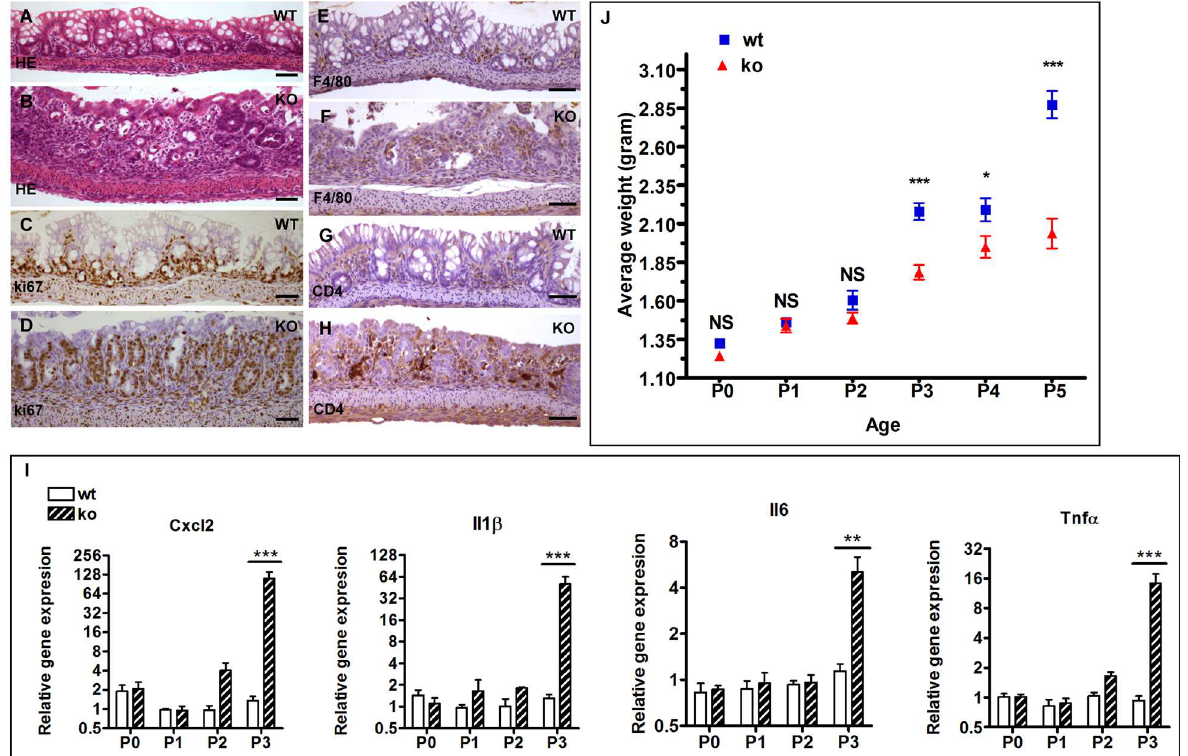
Fig 6. The IEC-specific hnRNPI knockout mice display colonic inflammation and weight gain decline at P3. (A) and (B) HE– stainedsections show the inflamedcolonicepitheliumin the knockout neonates(B). (C) and (D) Immunohistochemicalstaining with an anti-Ki67antibody shows hyperproliferation of the colonicepithelialcells in the knockout neonates. (E) to (H) Immunohistochemical stainingwith indicatedantibodiesshows increasednumber of inflammatory cells in the lamina propriaof the knockout neonates. (E) and (F) show macrophages, and (G) and (H) show CD4 positive T-cells. (I) Representative real-time PCR results show significantly increased expressionof pro-inflammatory cytokines and chemokines in the knockout colon at P3. Data are presented as mean values relativeto Gapdh ( ± s.e.m). N = 3–5 mice per group. Mice of the knockout group and the wild-typegroup are siblinglittermates. Mice from at least 3 litters were tested at each age. (J) Starting at P3, the knockoutneonatesdisplaydeclinein the weight gain. Each age containsat least 6 litters, and total 47 litters of 367 mice were analyzed.Data are presentedas mean values ± s.e.m. * p < 0.05; ** p < 0.01; *** p < 0.001; NS, not significant.WT, wild-type;KO, knockout. Scale bars, 50 μ